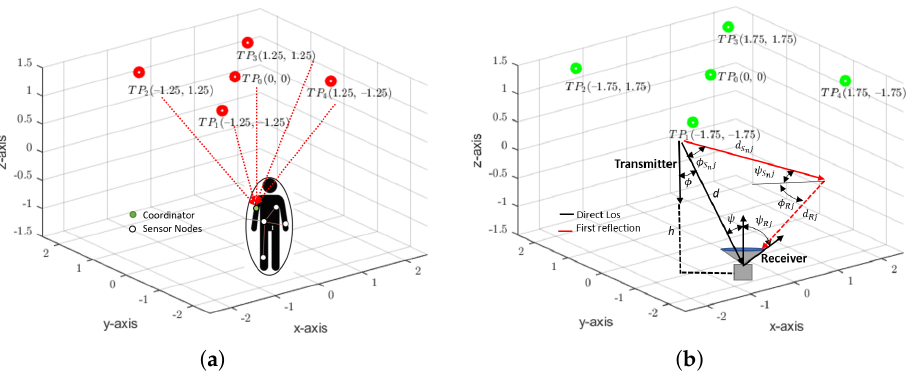
Figure 4. LED lamp placements for ( a ) centrally lit quadrants (CLQ) and ( b ) corner illuminated quadrants